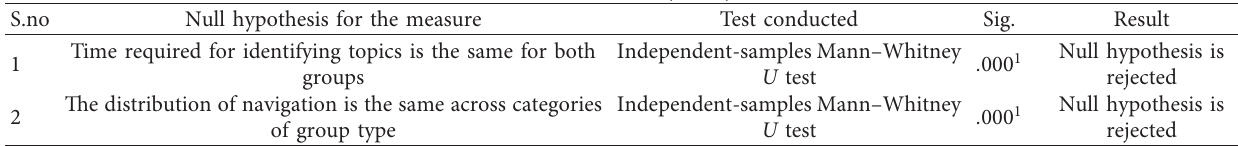
Figure 8: Efficiency of the system. Table 10: Efficiency analysis.